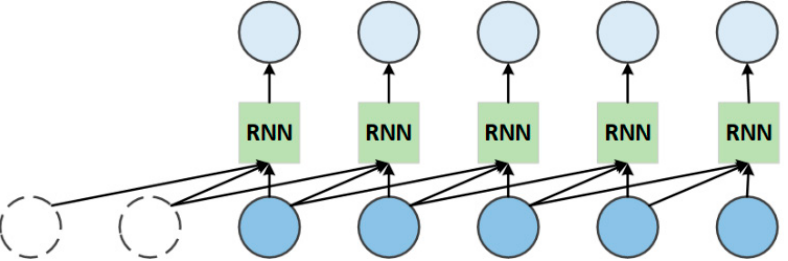
Figure 2. Local RNN module.